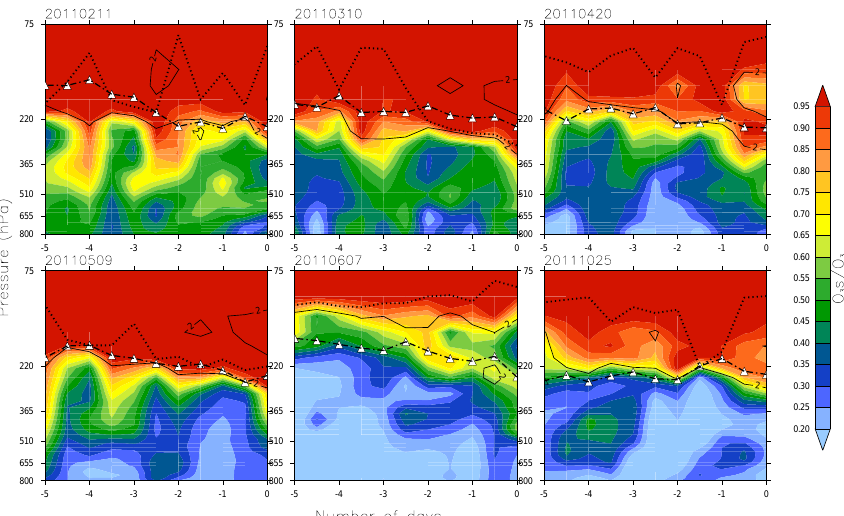
Figure 7. The vertical distribution of EMAC-simulated O 3 s / O 3 ratio along the trajectories with starting altitude of 11km over Nainital. The x axis shows the number of days backward in time and the y axis shows the pressure in hPa. White filled triangles show the pressure along the back-trajectory and the difference between two consecutive symbols on the line represent a time period of 12h. The dotted black line indicates the tropopause (LRT). The solid black line is the 2PVU contour.